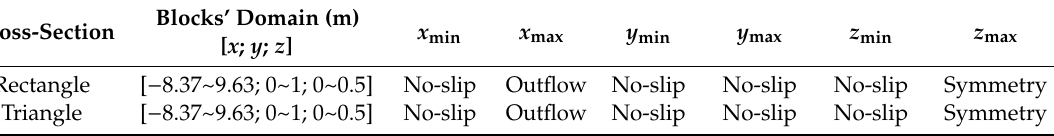
Table 1. Computational domain and boundary conditions.